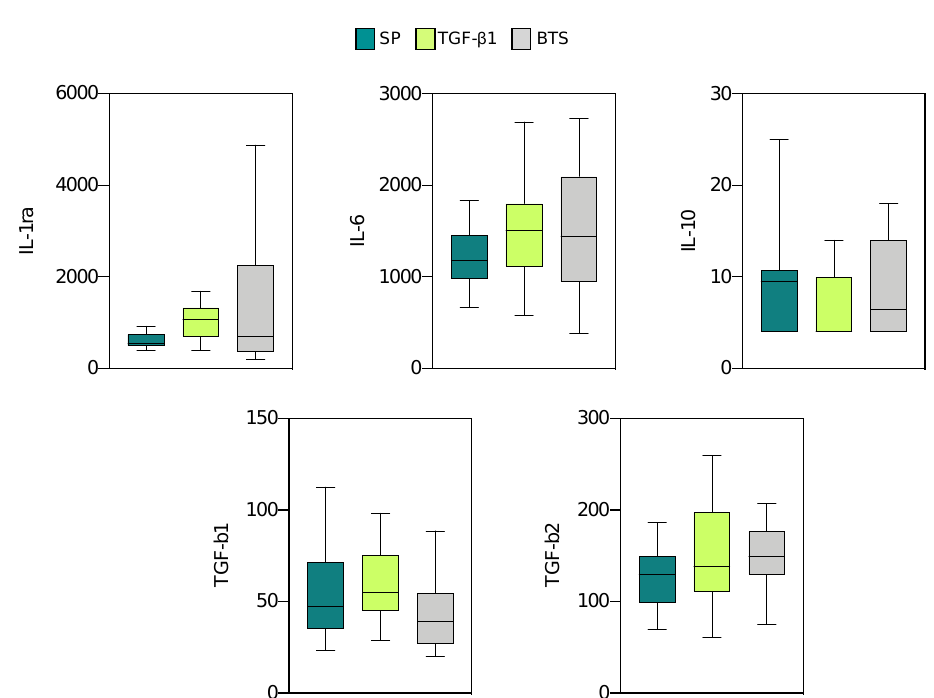
Figure 3. Levels of anti-inflammatory cytokines (pg/mL) on day 6 of the cycle in endometrial explants of “recipient” sows infused with 40 mL of SP, TGF- β 1 in BTS extender (TGF- β 1), or extender alone (BTS). These sows were not inseminated. The box plots show the median (line) and the interquartile ranges (boxes, Q1–Q3).